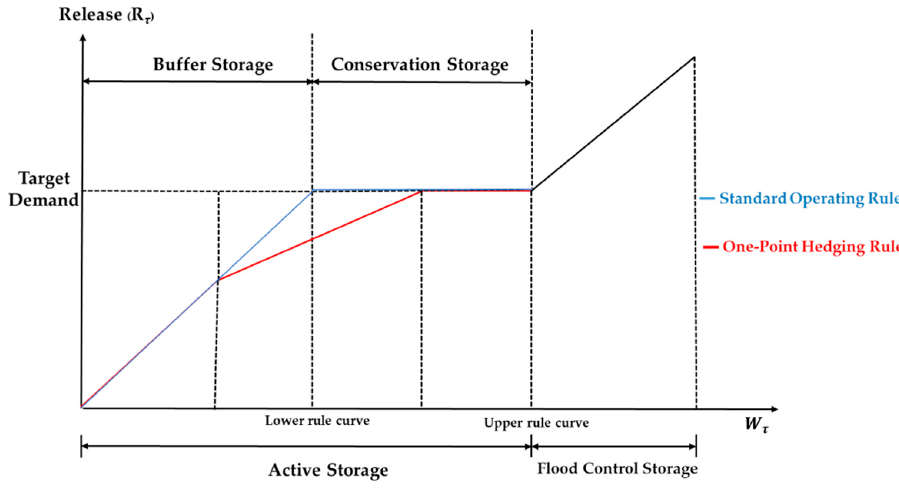
Figure 5. Criteria for SOP and HR water release.